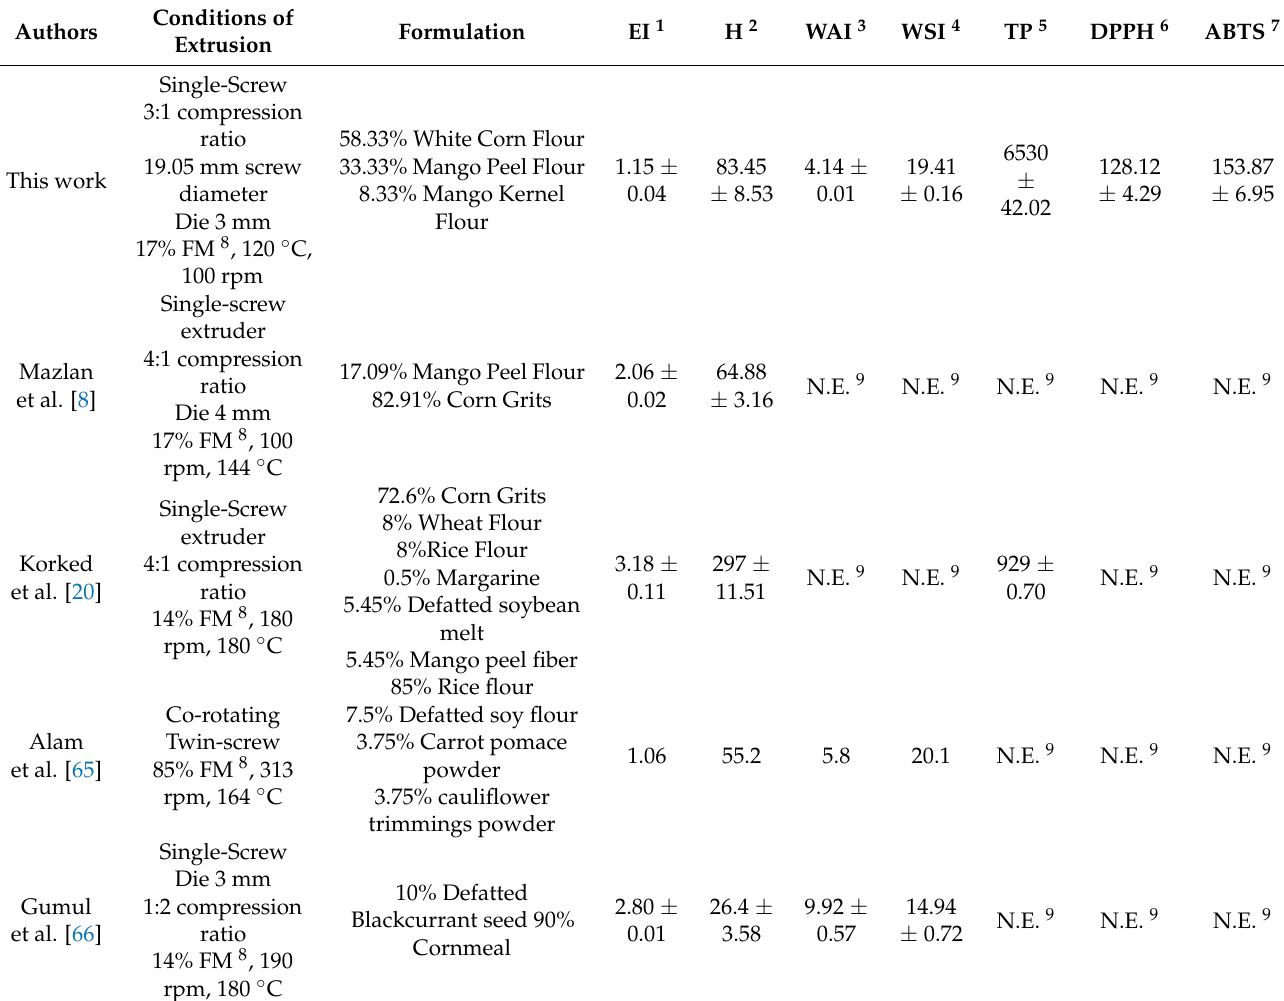
Table 6. Comparison of the physical and chemical characteristics of different extrudates developed with